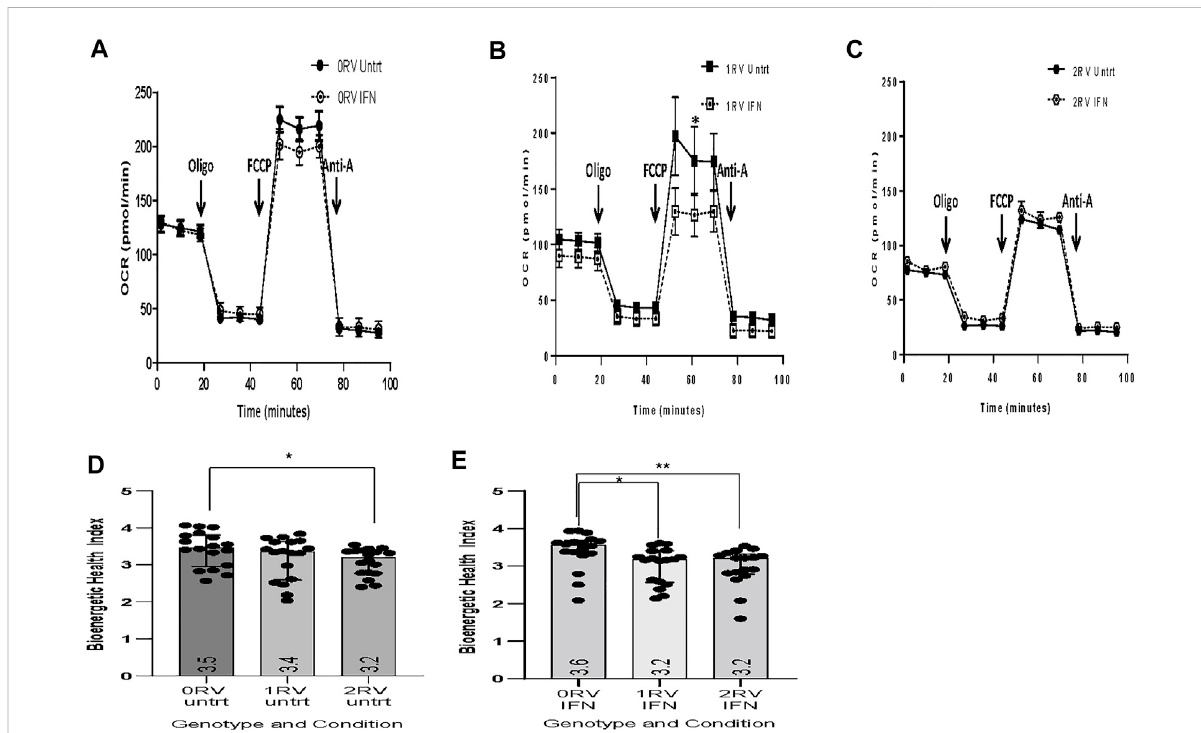
FIGURE 2 The bioenergetic pro fi les of HUVECs across genotype. The bioenergetic pro fi les of HUVECs across genotype. APOL1 risk variant associations with attenuated mitochondrial function including maximum respiration, reserve respiration capacity, and bioenergetic health index. Live HUVEC metabolic assays were performed using the Seahorse XF platform. Representative tracings by APOL1 genotype are shown in fi gures (A – C) . In this assay,oxygenconsumptionrate(OCR)wasmeasuredatbaseline,uponoligomycin(oligo),FCCP,andantimycinAexposure. (D , E) Bioenergetic healthindex(BHI)calculatedby APOL1 genotypeandexposure (5experimentsaveragedrepresenting 9HUVECdonors).Genotypesarerepresented as follows: 0RV, 1RV, and 2RV (RV = risk variant). Exposure conditions included: no treatment (Untrt) or IFN Ɣ (50 pg/ml, 18 h). p -values were calculated using Kruskal – Wallis (KW) one-way analysis of variance for cross genotype comparisons. Where the KW models were signi fi cant, post- hoc Dunn ’ s multiple comparisons tests were completed. * indicates p < 0.05, and ** indicates p <